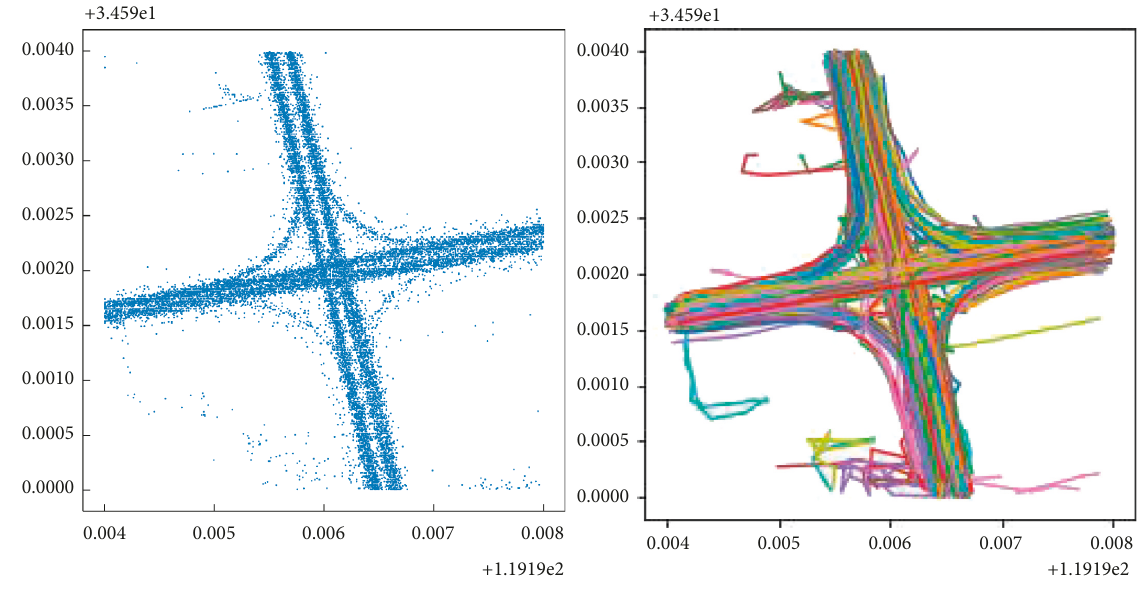
Figure 4: Scatter of GPS trajectory for experiment